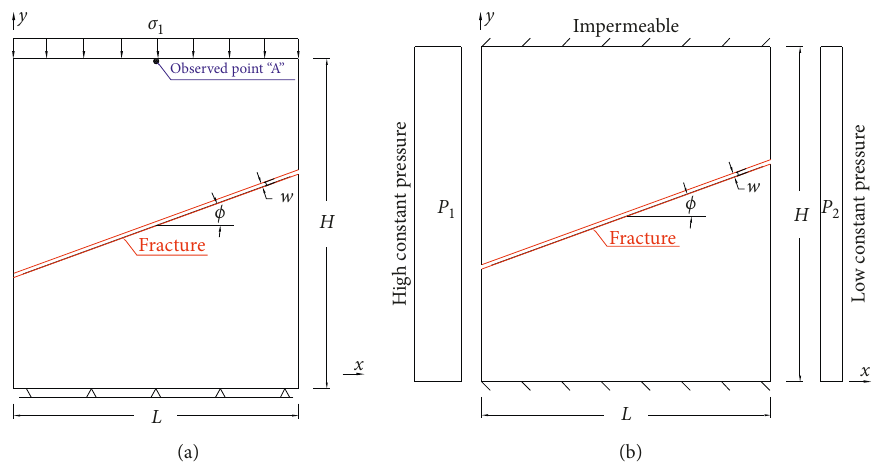
Figure 4: Geometric model with boundary conditions of the purely (a) mechanical and (b) hydraulic verification